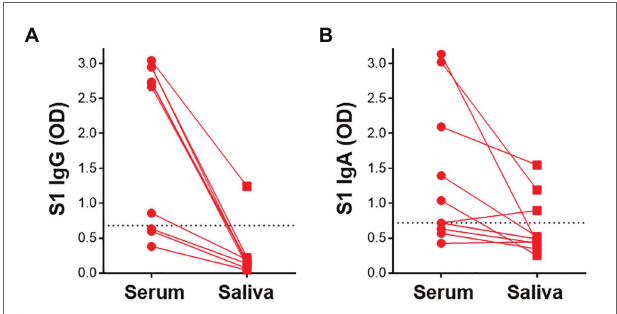
FIGURE 6 | Detection of S1-specific antibodies in saliva. Comparison of paired serum and saliva S1-specific IgG (A) and IgA ( B ; n = 10). Dotted lines indicate the positivity threshold for